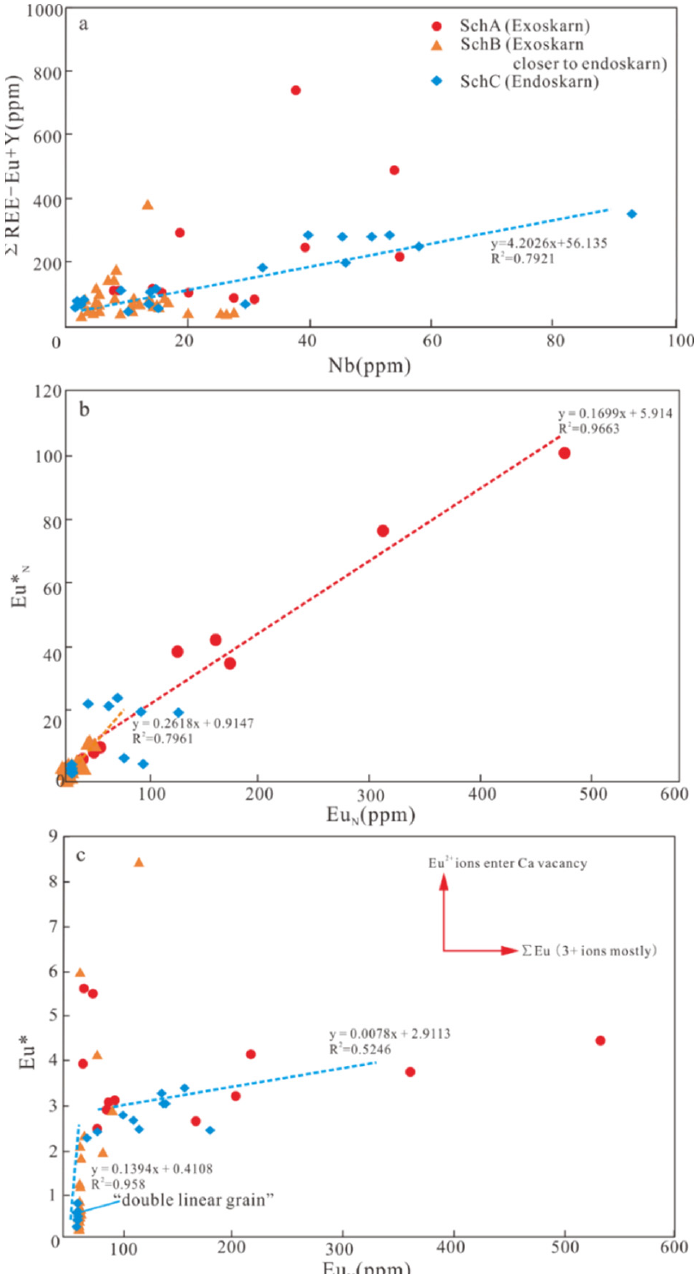
Figure 9. Trace element plots of Nb and REE characteristics showing the substitution mechanism (The normalization values were taken from Taylor and McLennan (1985) [33]). ( a ) Diagram of Nb vs. Σ REE-Eu + Y, showing the substitution mechanism in scheelite. ( b ) Diagram of Eu N vs. Eu* N , showing the correlation between Eu* and Eu* N , ( c ) Diagram of Eu N vs. Eu* , indicating the Eu* N is composed of Eu 2+ and Eu 3+